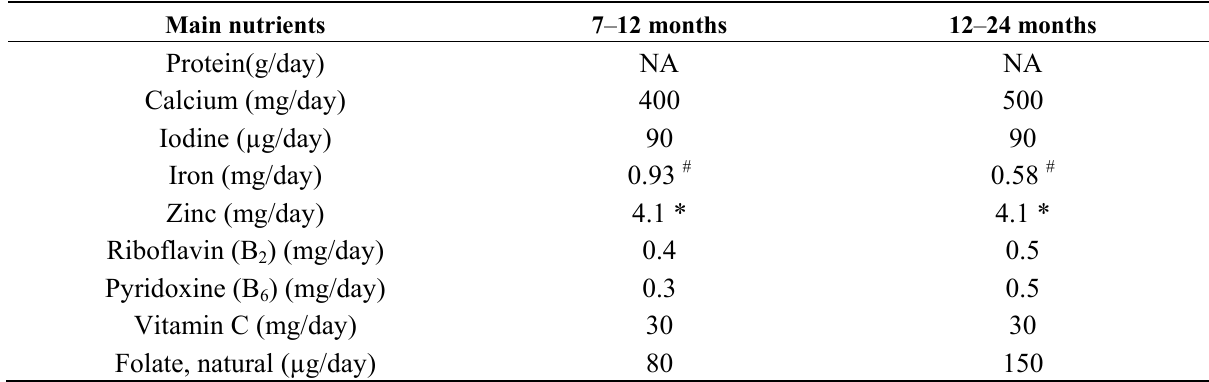
Table 6. Recommended nutrient intakes for infants aged 7–12months and 12–24